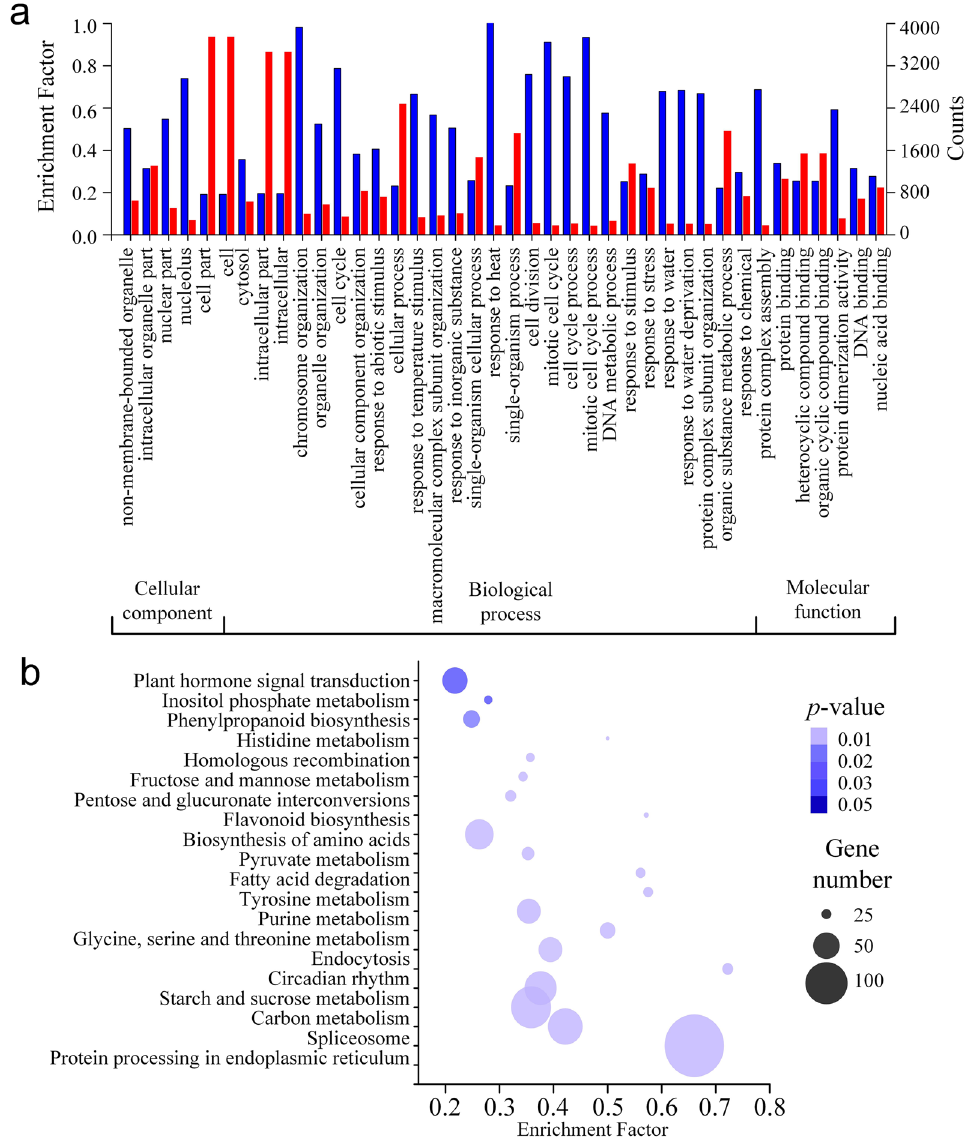
Figure 2. GO and KEGG pathway enrichment of DEGs during the floral development in tree peony ’High Noon’. ( a ) GO classification of DEGs during the floral development. The red columns represent the enriched DEG counts and the blue columns represent the enrichment factor; ( b ) KEGG pathways classification of DEGs during the floral development. The size of bubble represents gene number and the color represents p